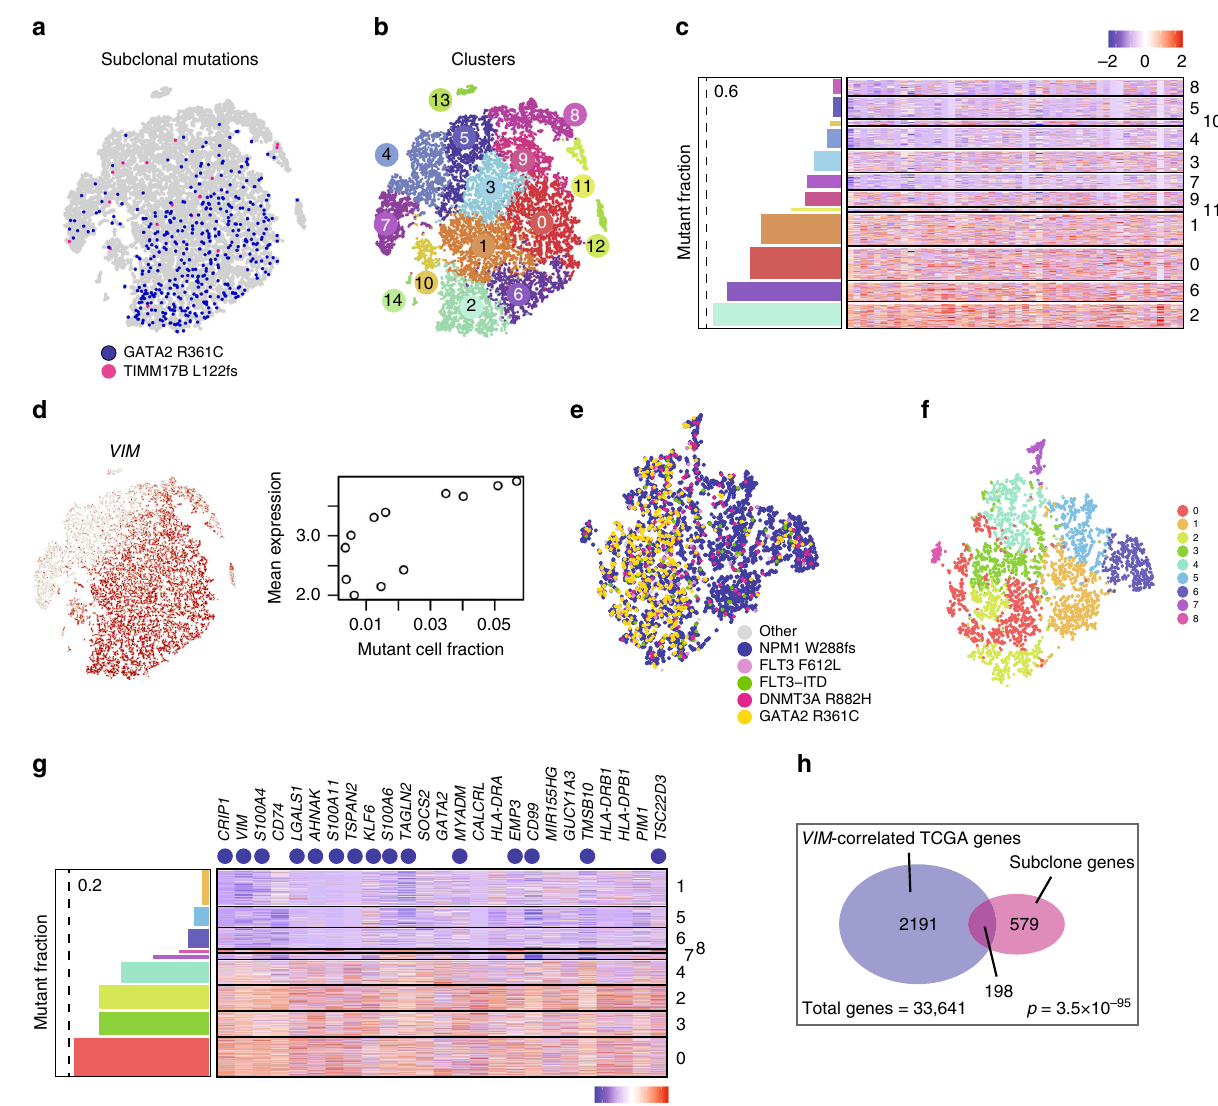
Fig. 5 GATA2 R361C Subclonal expression signature. a t-SNE projection showing mutation-expressing cells in blue ( GATA2 R361C ) and pink ( TIMM17B L122fs ). b Cells colored according to graph-based cluster assignment. c Heatmap of top 50 mutation-dependent genes, with bar graph showing mutant cell fraction in each AML cluster (labeled to the right of the heatmap). d Cells colored according to VIM expression (left), and scatterplot showing average VIM expression in each cluster as a function of the subclonal mutation fraction of each cluster (right). e t-SNE plot constructed from mutant cells, which are colored according to the mutation they contain: GATA2 R361C , yellow; DNMT3A R882H , pink; FLT3 -ITD, green; FLT3 F612L , purple; NPM1 W288FS ; other somatic mutation(s), gray. f Mutant cells colored according to graph-based cluster. g Heatmap of top 25 subclonal mutation-dependent genes, with bar graph showing mutant cell fraction in each cluster (labeled to the right of the heatmap). Genes that are highly correlated with VIM in TCGA are indicated with blue dots. h Venn diagram indicating gene sets used to identify the VIM